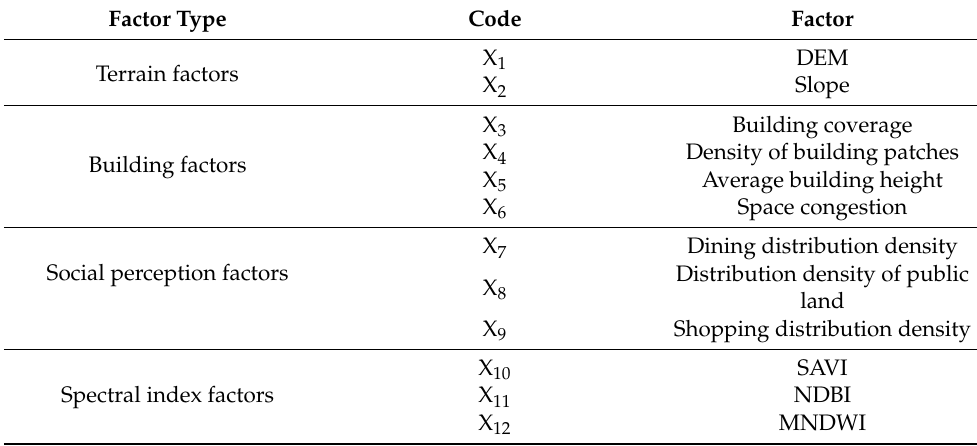
Table 2. Factors influencing remote sensing ecological quality.